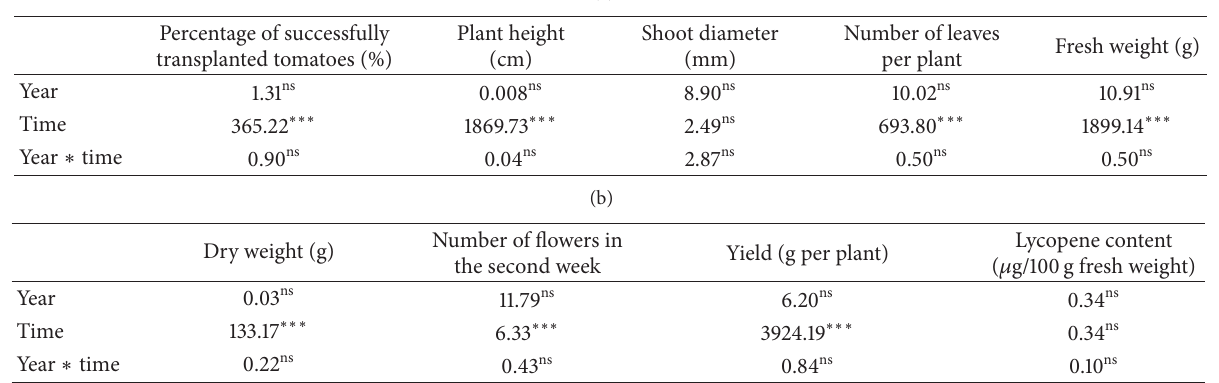
Table 1: Analysis of variance ( 𝐹 values).